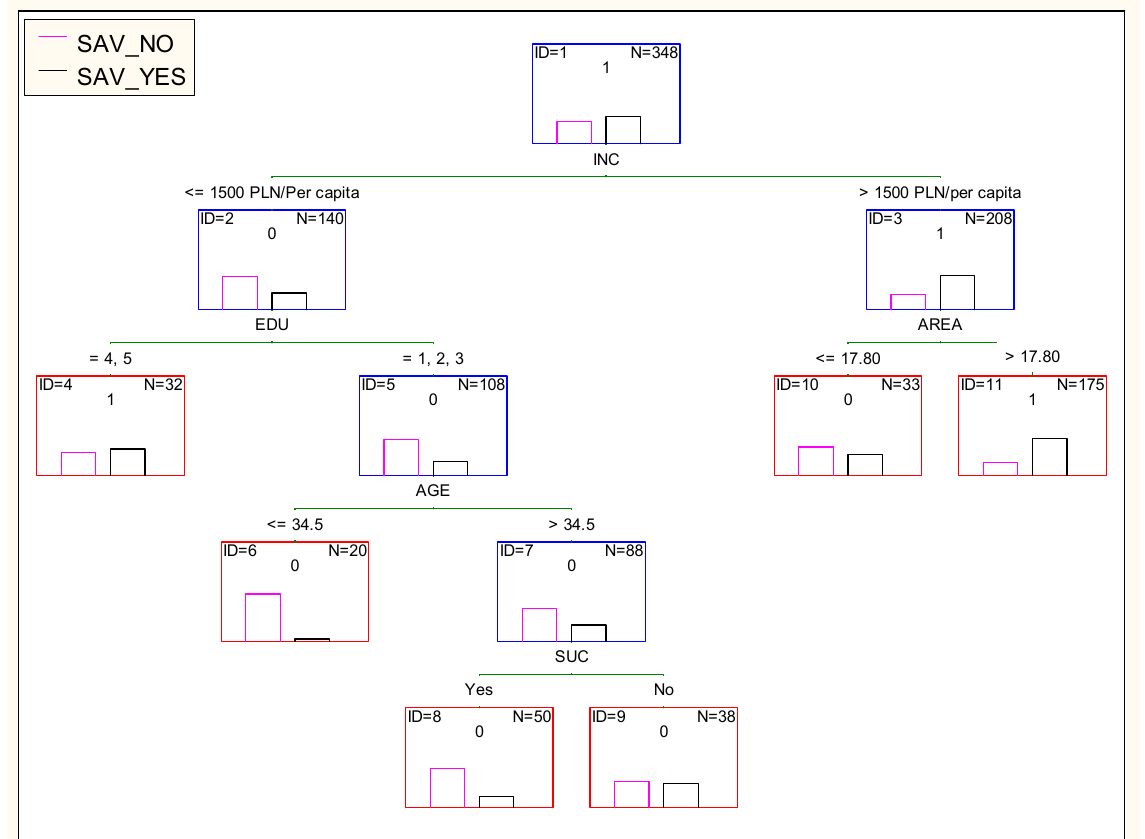
Figure 4. Motives for saving money by the surveyed agricultural households ( n = 191). Note: